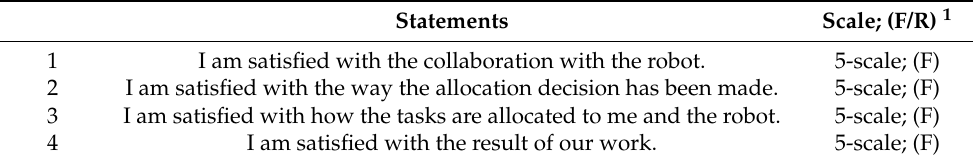
Table A3. Satisfaction questionnaire (shortened and adapted based on